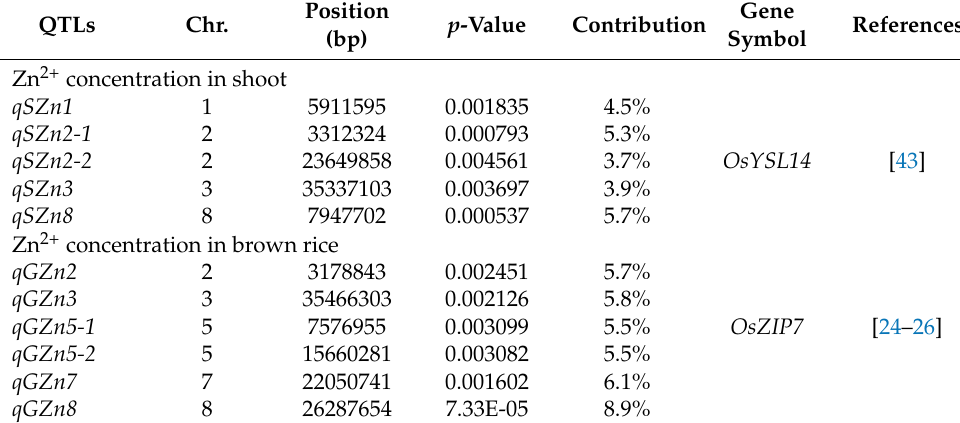
Table 1. QTLs associated with Zn 2+ concentration in shoots at the seedling stage and grains at the mature stage in the MAGIC population.